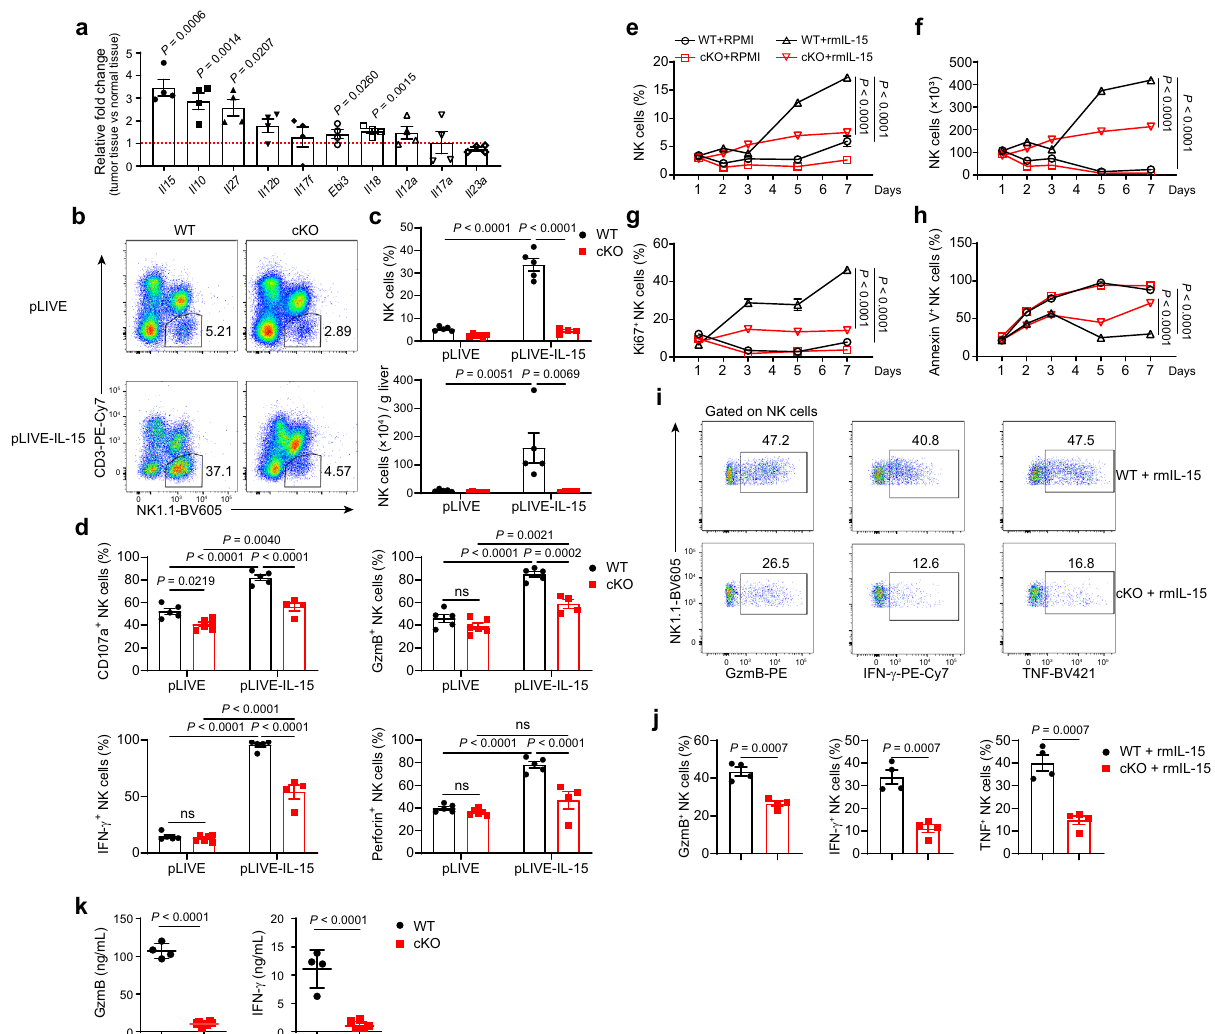
Fig. 5 METTL3-de fi cient NK cells are hyporesponsive to IL-15 stimulation. a Fold changes of cytokine expression in tumor-bearing liver tissue ( n = 4) from WT mice injected with 2 × 10 5 MC38 cells into the spleen 22 days previously, compared with normal liver tissue ( n = 4), were determined by RT- qPCR, normalized to β -actin expression. b – d WT ( n = 5/group) or cKO mice ( n = 6 for pLIVE group; n = 4 for the pLIVE-IL-15 group) that received a hydrodynamic injection of pLIVE-IL-15 or pLIVE control plasmid 1 month previously were harvested for fl ow-cytometric analyses. b Representative plots showing expression of NK1.1 and CD3 in liver mononuclear cells from WT and cKO mice. c Percentages or absolute numbers of liver NK cells from WT and cKO mice. d Percentages of CD107a-, GzmB-, IFN- γ -, and Perforin-positive NK cells among total NK cells in splenocytes 4 h after stimulated with PMA and ionomycin. e – h Splenocytes from WT or cKO mice were cultured with the presence or absence of rmIL-15 (100 ng/mL) for the indicated times, and then analyzed by fl ow cytometry. Percentages ( e ) and absolute numbers ( f ) of NK cells among splenocytes are shown ( n = 4/group). g Percentages of Ki67- positive cells among NK cells ( n = 3/group). h Percentages of Annexin V-positive cells among NK cells ( n = 4/group). i , j Splenocytes from WT mice or cKO mice were stimulated with rmIL-15 (10 ng/mL) for 7 days, and then collected for stimulation with PMA and ionomycin, followed by fl ow cytometric analyses. Representative plots ( i ) and percentages ( j ) of expression of GzmB, IFN- γ , and TNF in NK cells from WT and cKO mice ( n = 4/group). k Protein concentration of GzmB and IFN- γ in the supernatant of cultured NK cells in the condition of rmIL-15 (50 ng/mL) for 9 days from WT ( n = 4) or cKO ( n = 6) mice. Each symbol represents an individual mouse ( c , d ) or an individual well of a cell culture plate ( e – h , j , k ). Data are the mean ± SEM (ns, not signi fi cant; unpaired two-tailed t test ( a , j , k ) or one-way ANOVA ( c , d ) or two-way ANOVA ( e – h )). Source data are provided as a Source Data fi le. Data represent at least two independent experiments ( a – k